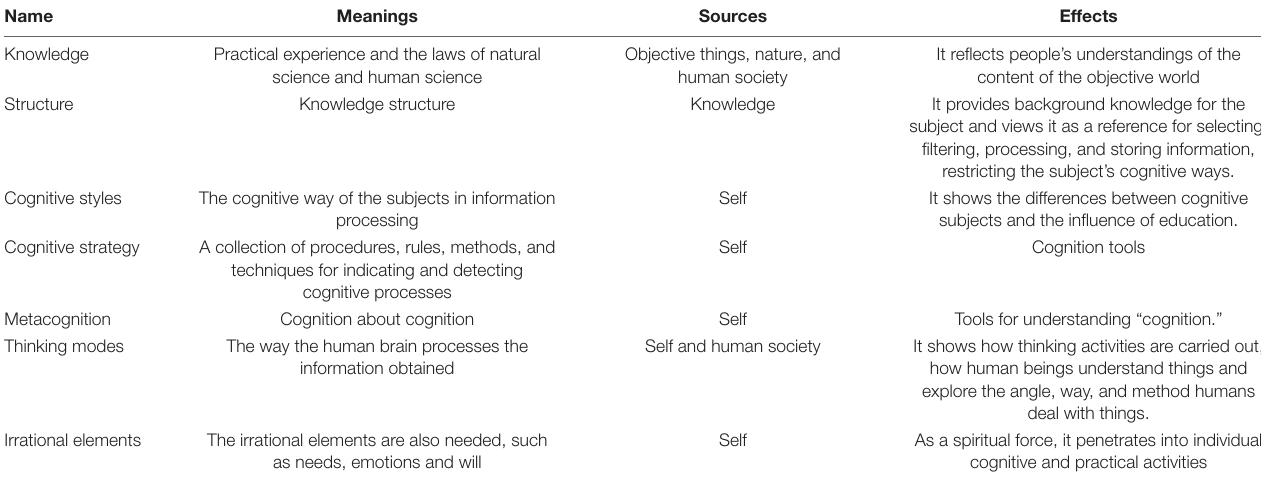
FIGURE 2 | Information processing model. TABLE 2 | Elements of cognitive structures.